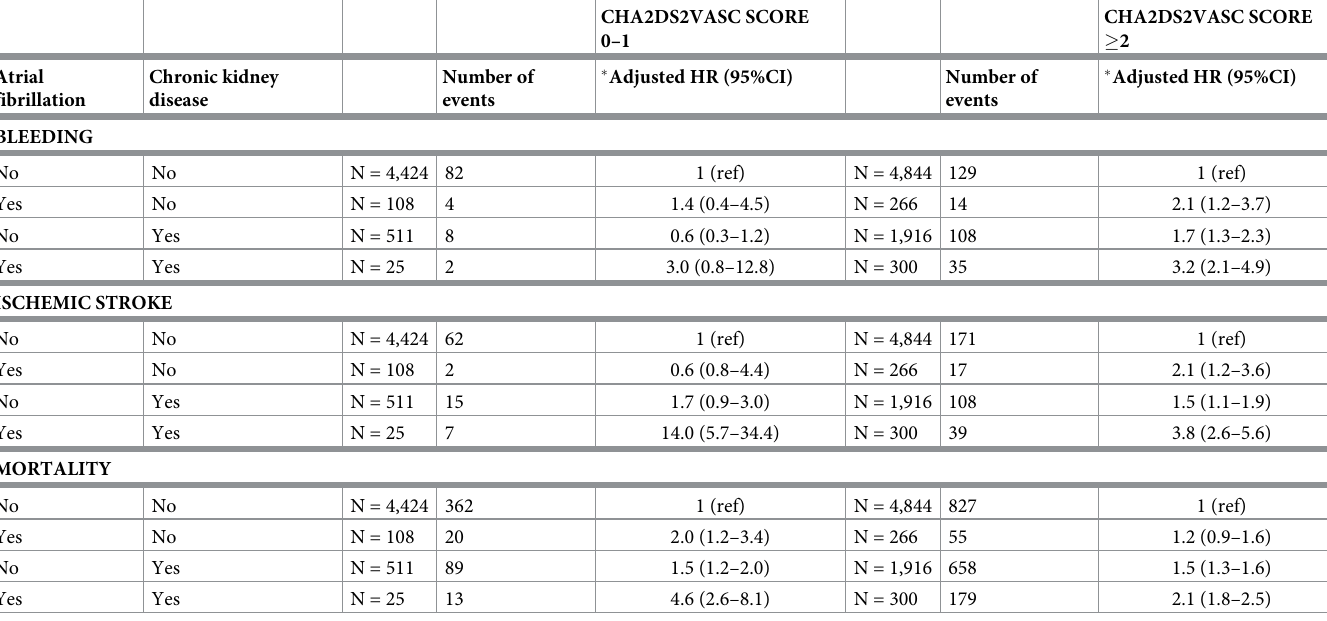
Table 3. Combination of atrial fibrillation and chronic kidney disease and risk of bleeding, ischemic stroke and mortality stratified for CHA2DS2VASC